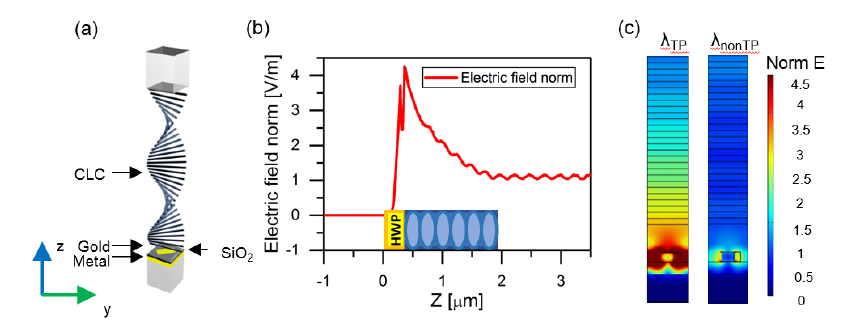
Figure 5. ( a ) Structure of the CLC combined with metasurfaces. ( b ) The maximum of the electric field near CLC–metasurface interface. ( c ) Distribution of normalized electric fields at the resonant and nonresonant wavelengths. Field distribution at the resonant wavelength in x - y plane is shown in the Supplementary